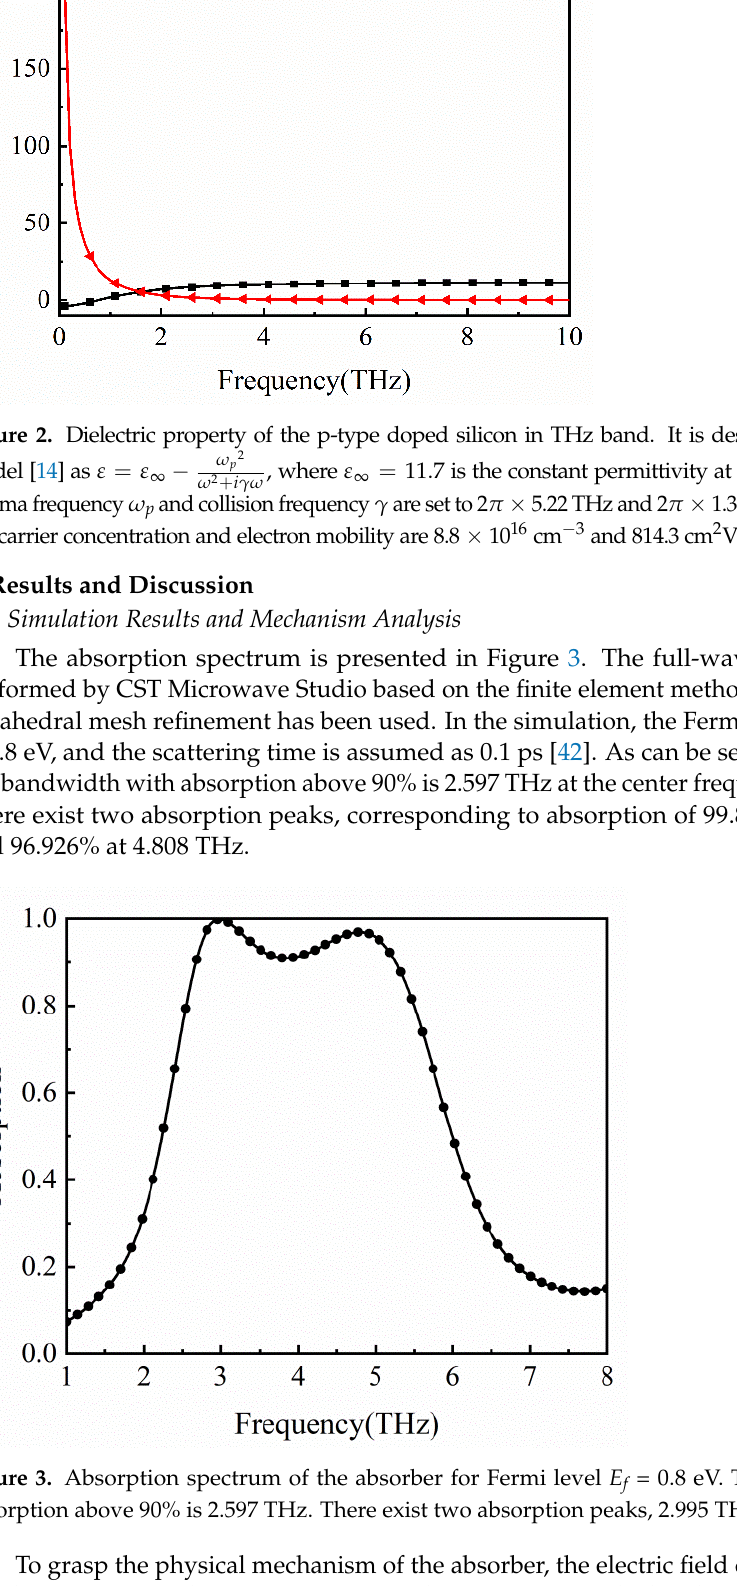
Figure 3. Absorption spectrum of the absorber for Fermi level E f = 0.8 eV. The bandwidth with absorption above 90% is 2.597 THz. There exist two absorption peaks, 2.995 THz and 4.808 THz. To grasp the physical mechanism of the absorber, the electric field distributions of the graphene composite layer at 2.995 THz and 4.808 THz are calculated, as shown in Figure